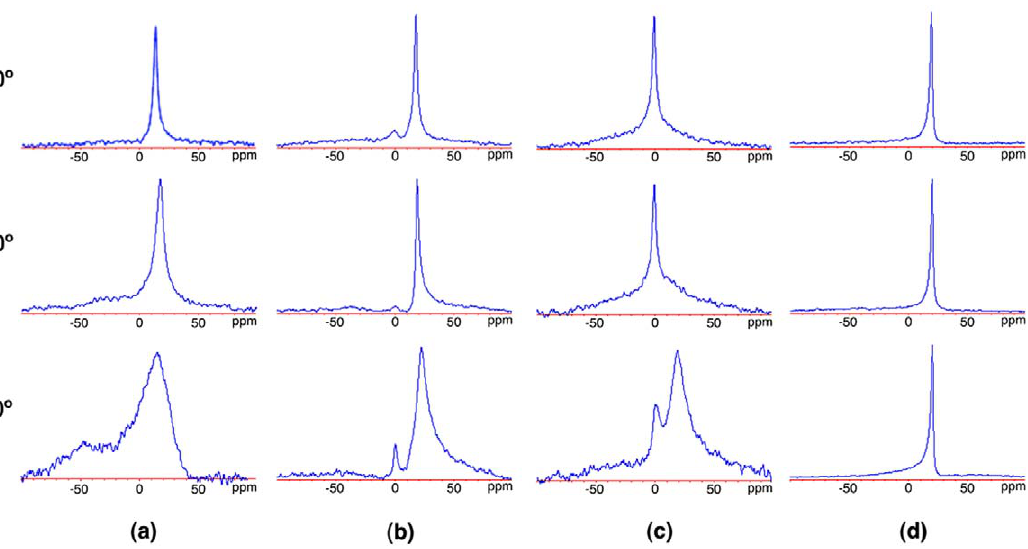
Figure 7. 31 P-NMR spectra of a DPPC:surfactant systems ([DPPC]=30 mg/mL, x (surfactant)=20 mol%), in the (a) absence of surfactant, and in the presence of (b) DTAB, (c) 12-2-12 and (d) 12-10-12. The chemical shift is represented in the horizontal axis.